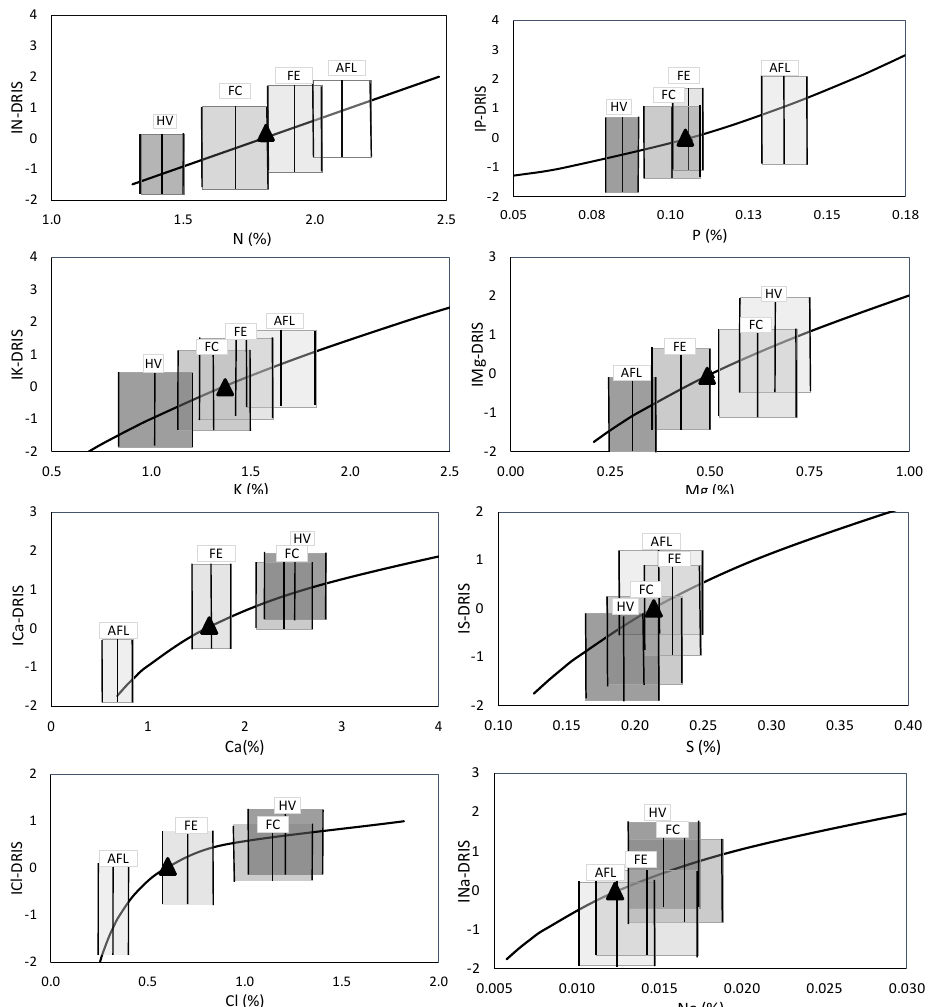
Figure 3. Optimal range of leaf macronutrients in four phenological stages: AF (After flowering), FE (fruit enlargement), FC (fruit colouring) and HV (harvest period). The vertical bar in the middle of each square represents the mean value of each phenological stage. The left vertical bar denotes the lower limit of the optimal range (−2/3 SD). The right bar indicates the upper limit of the optimal range (+2/3 SD). A black triangle represents the BP (I DRIS = 0).